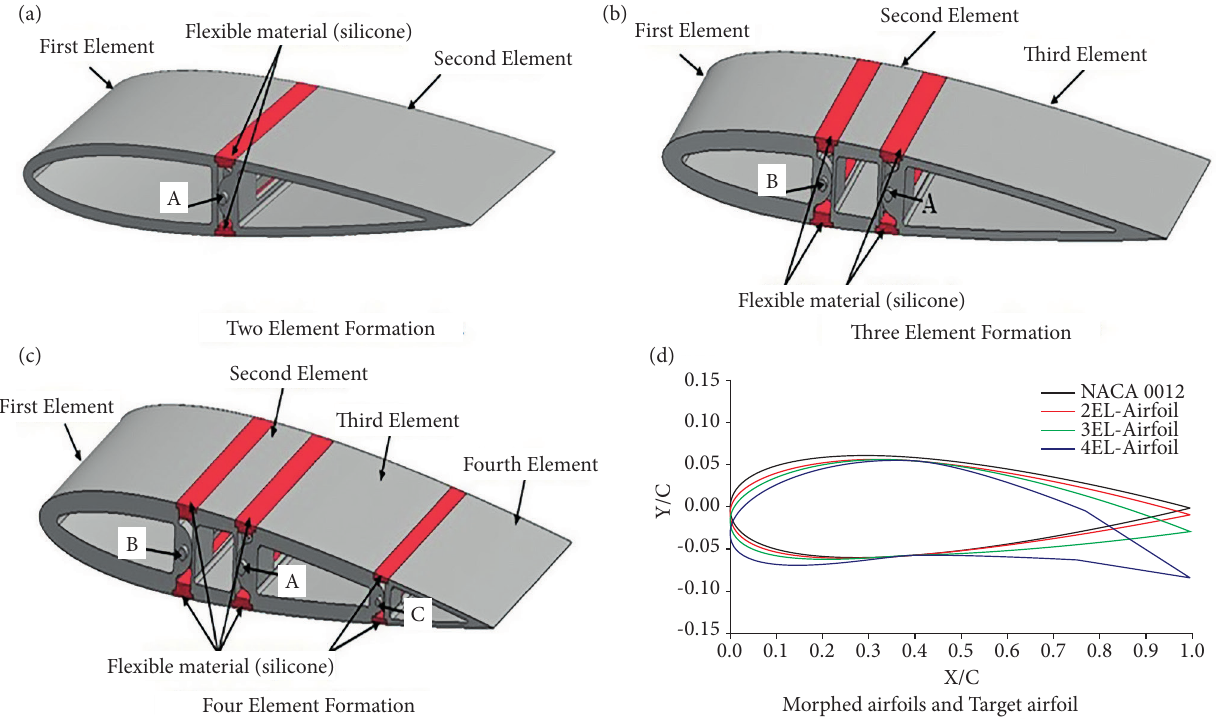
Figure 2. Representation of camber morphing airfoil